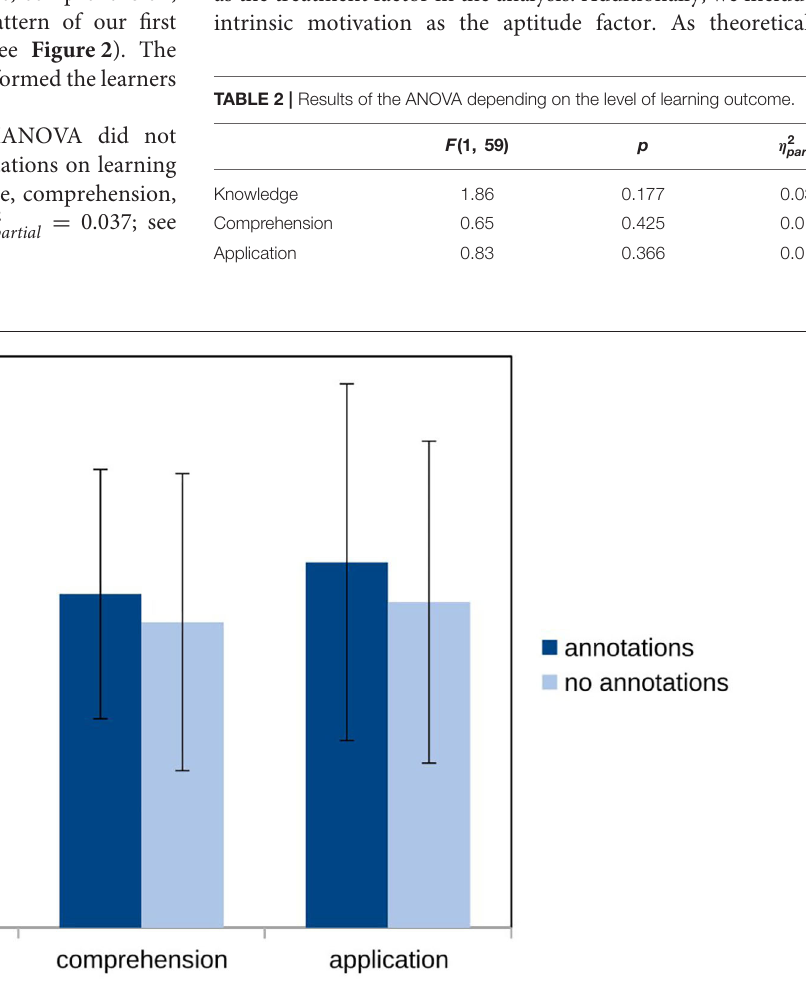
Frontiers in Psychology |